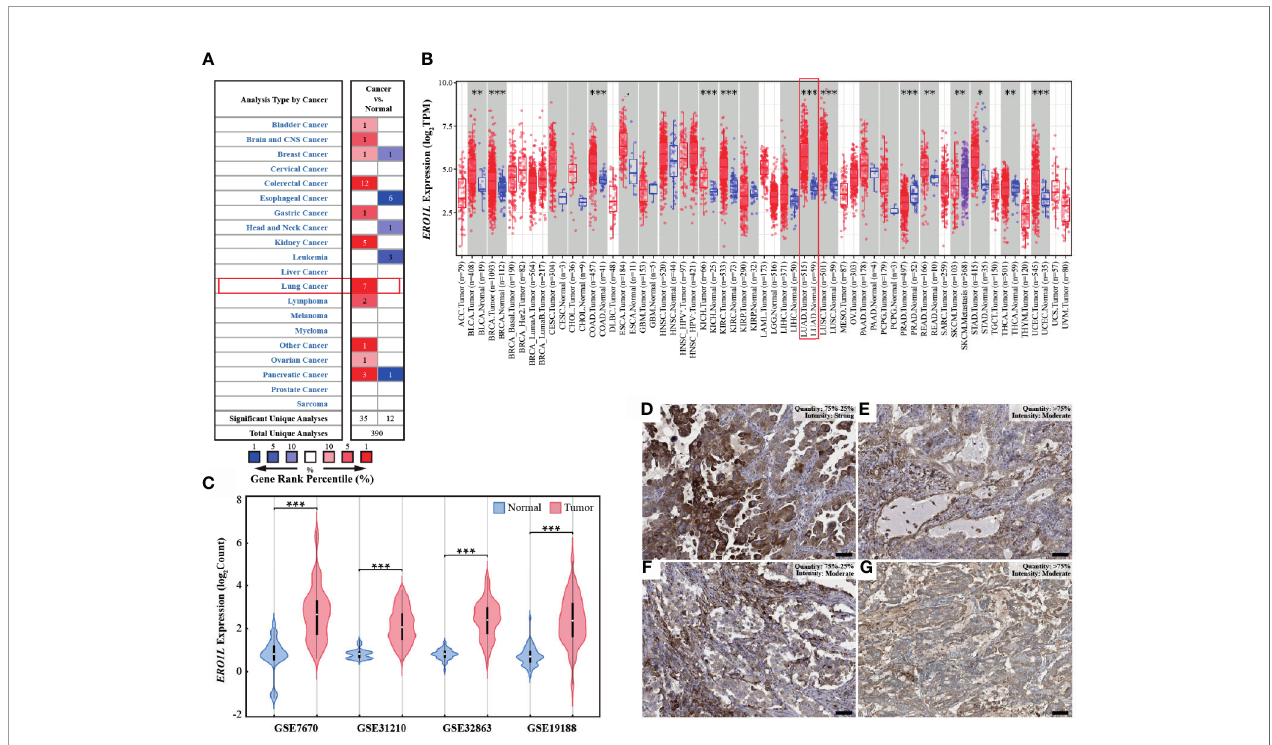
FIGURE 1 | ERO1L expression levels in pan-cancer and LUAD. (A) Expression levels of ERO1L mRNA in pan-cancer, compared with normal tissues in the Oncomine database. The number in each cell denotes the number of datasets. (B) Expression levels of ERO1L mRNA in pan-cancer, compared with normal tissue from the TCGA database. (C) Expression levels of ERO1L mRNA in LUAD across four GEO datasets. (D-G) Expression levels of ERO1L protein in four patients with LUAD from the HPA database. Scale bar: 50 µm. * p < 0.05; ** p < 0.01; *** p <